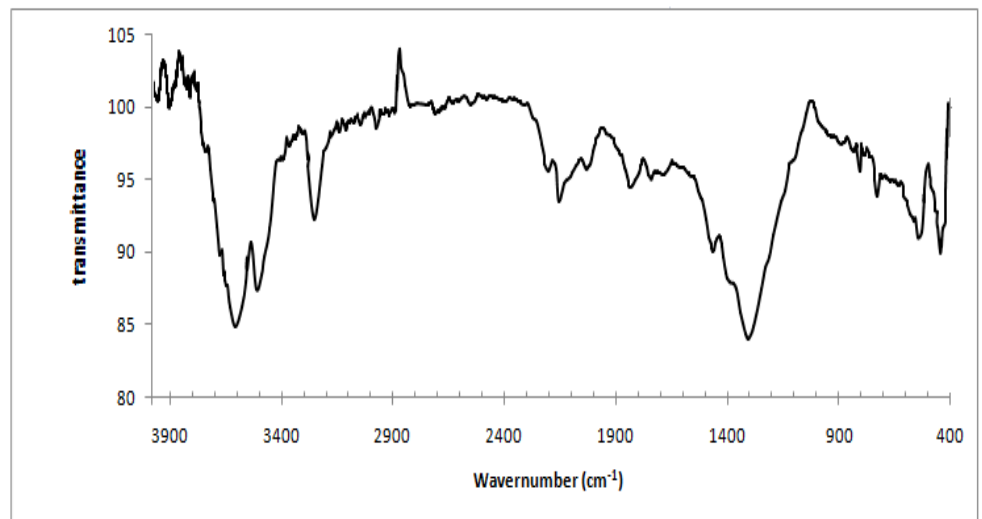
Fig.7: Fourier transform infrared spectroscopy (FTIR) spectrum of polypyrrole thin